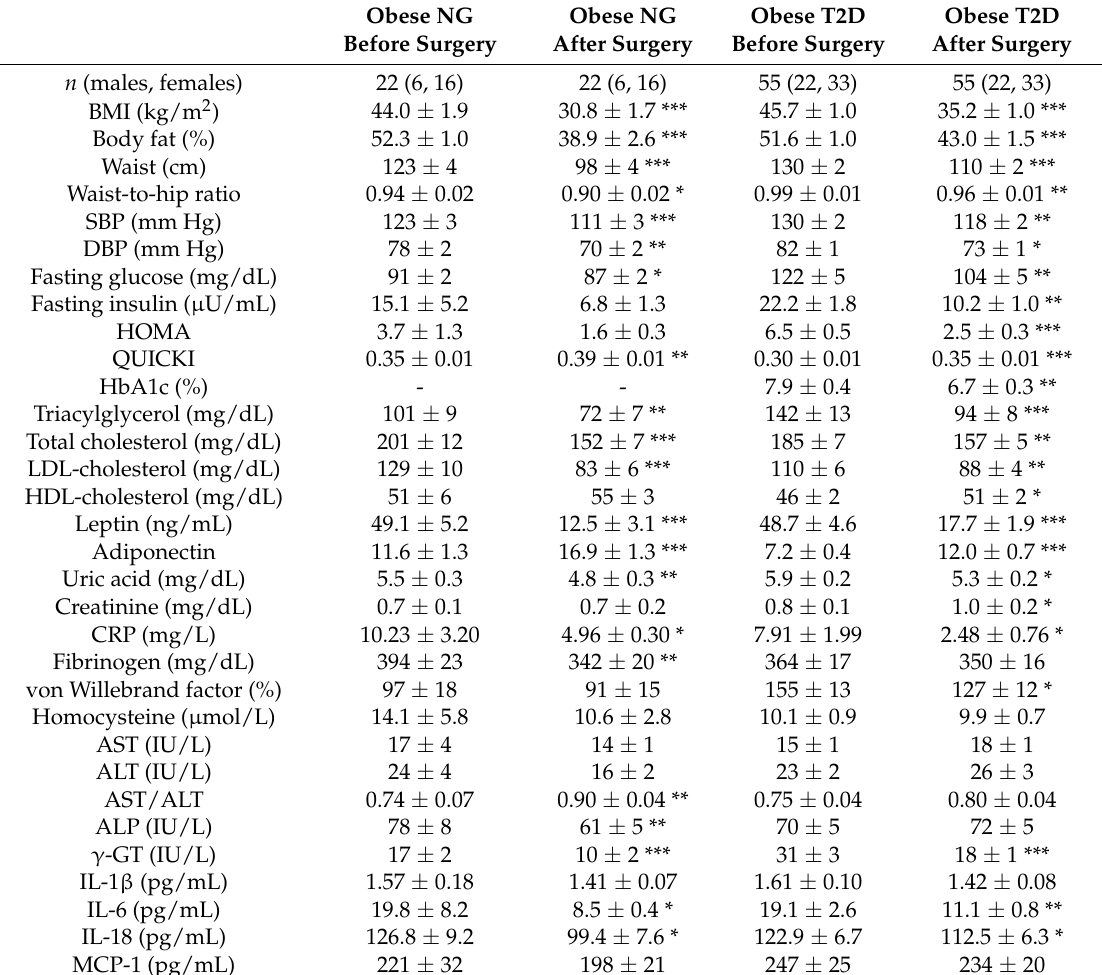
Table 2. Effects of weight loss in obese patients after Roux-en-Y gastric bypass (RYGB). Obese NG Obese NG Obese T2D Obese T2D Before Surgery After Surgery Before Surgery After Surgery n (males, females) 22 (6, 16) 22 (6, 16) BMI (kg/m 2 ) Waist (cm) Waist-to-hip ratio